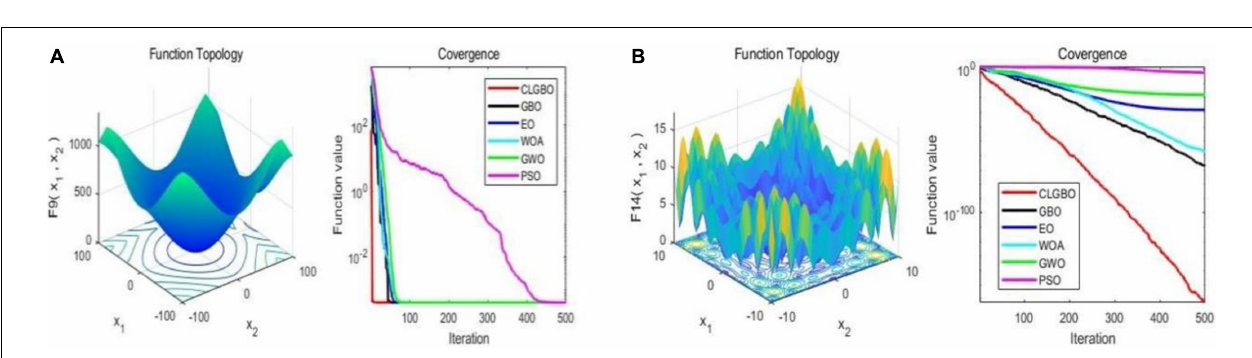
FIGURE 4 | 3D representation and convergence curve of two multimodal functions. (A) the result of the function F9. (B) the result of the function F14.